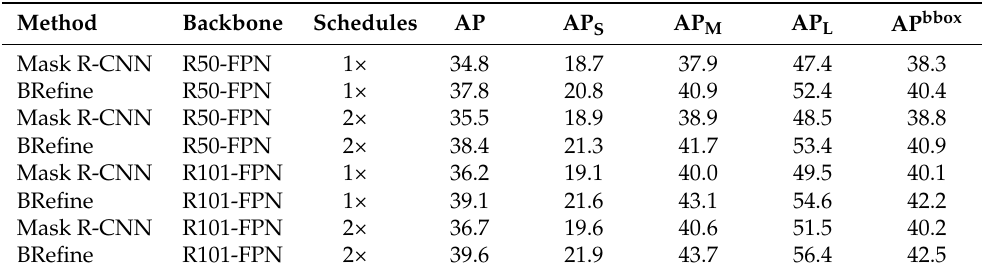
Table 1. Comparison with Mask R-CNN on COCO